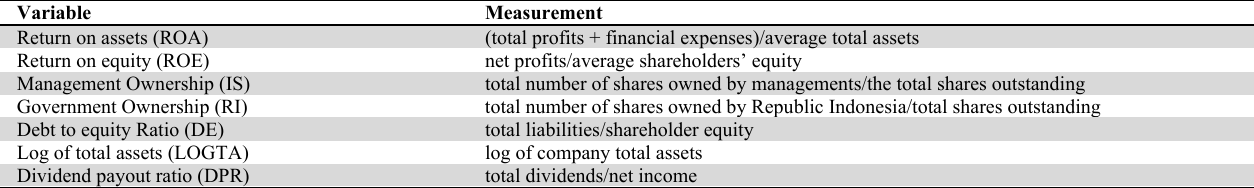
Research variables. Variable Measurement Return on assets (ROA) (total profits + financial expenses)/average total assets Return on equity